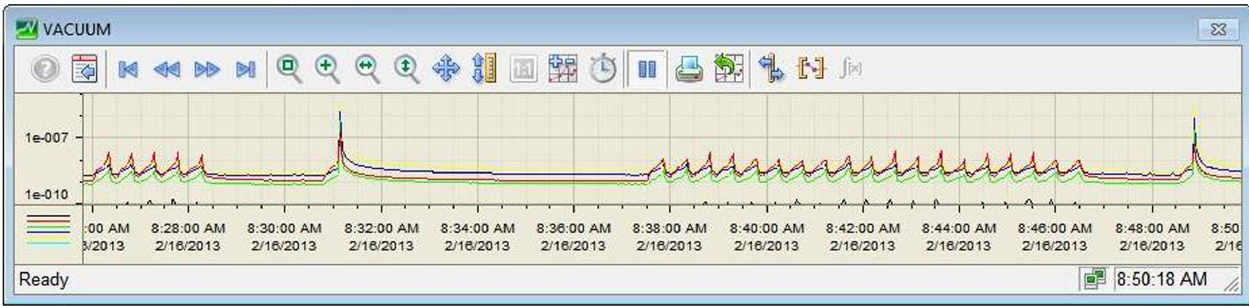
FIG. 7. Time profile of the vacuum at the MKD dump kickers immediately upstream of the blades under test. The vacuum spikes at 08 ∶ 31 a.m. and 08 ∶ 49 a.m. (local time at CERN, Geneva, Switzerland) are in conjunction to the test of the vertical and horizontal blades, respectively. All other small spikes happened at every scraping action when checking the performance of the blades with operational settings before and after the